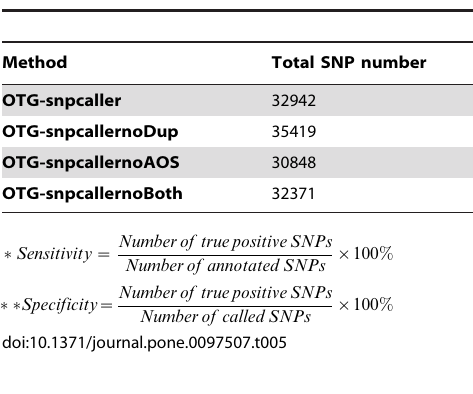
Table 5. The performance comparison of OTG-snpcaller with OTG-snpcallernoDup (no RDAST), OTG-snpcallernoAOS (noAOS), and OTG-snpcallernoBoth (no RDAST or